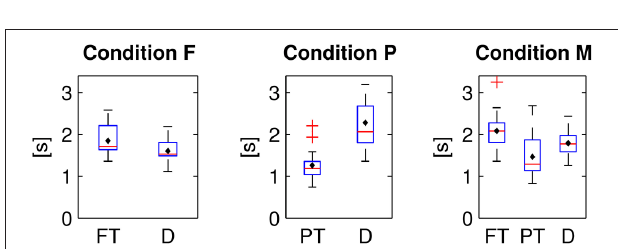
FIGURE 9 | Latencies between first appearance and first fixation of foveal (FT) and peripheral targets (PT) and distractors (D) in the three experimental